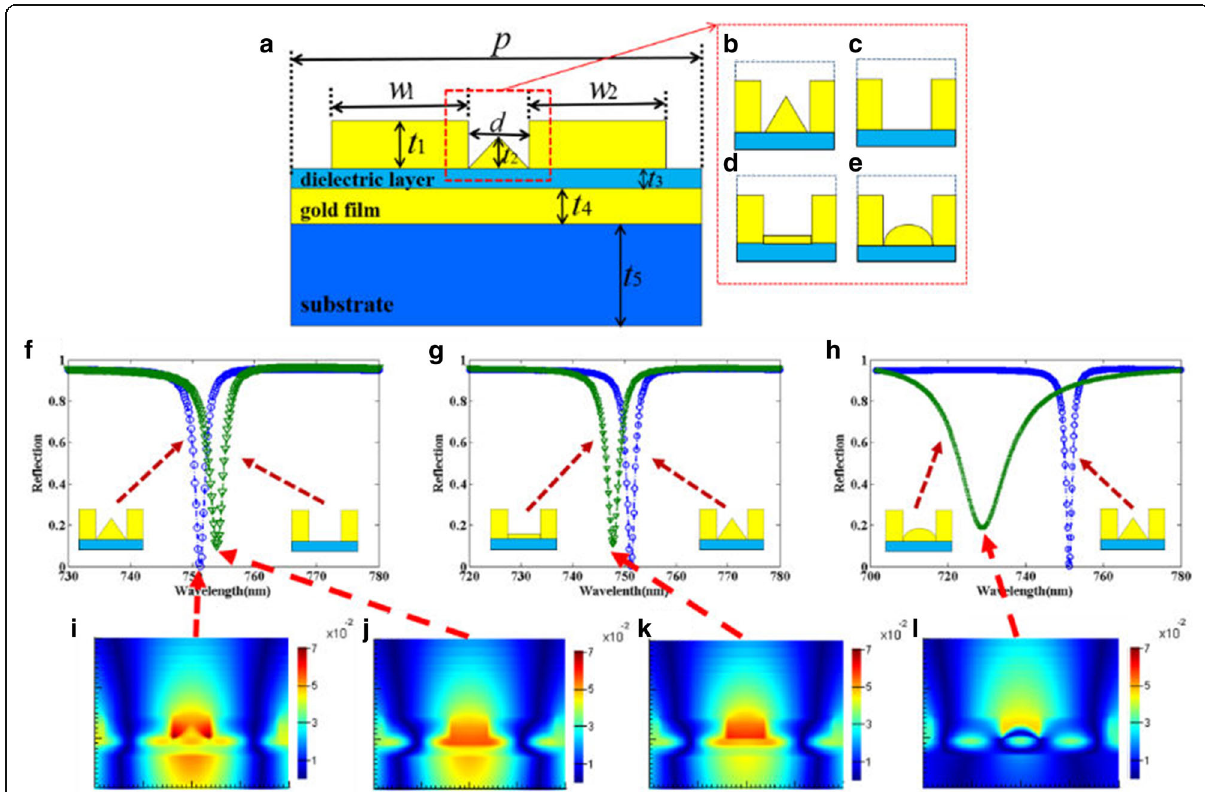
Fig. 5 a – e Schematic of the proposed metamaterial with different nanostructures of one unit cell. f – h Reflection spectra of the different structures. i – l Distributions of the magnetic field H at the resonant peak of the corresponding